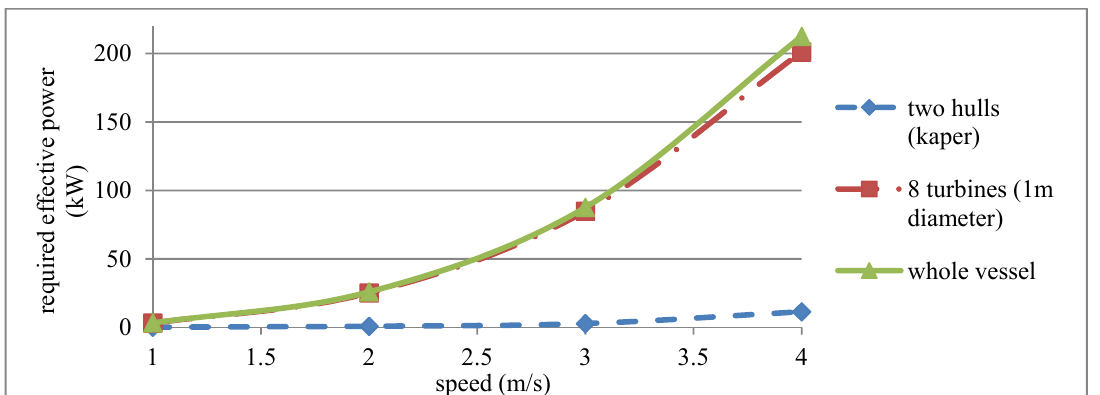
Figure 8. Required effective power for the vessel and its